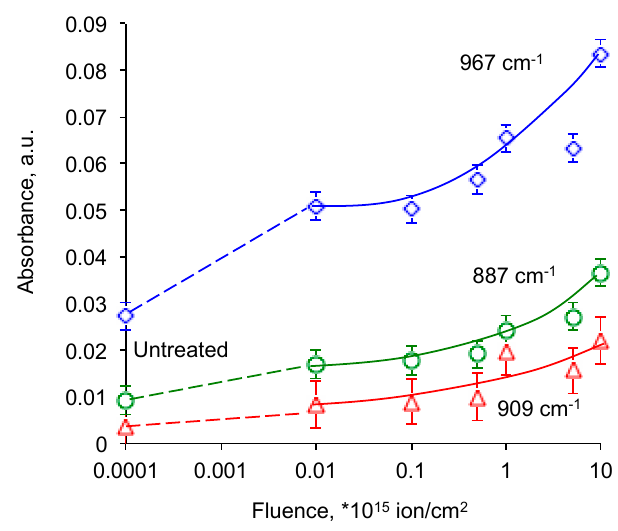
Figure A7. Normalized absorbance at 967 cm − 1 line of vinylene group, at 887 cm − 1 line of vinyliden group and at 909 cm − 1 line of vinyl group in FTIR ATR spectra of EPDM rubber with fluence of PIII without grid.